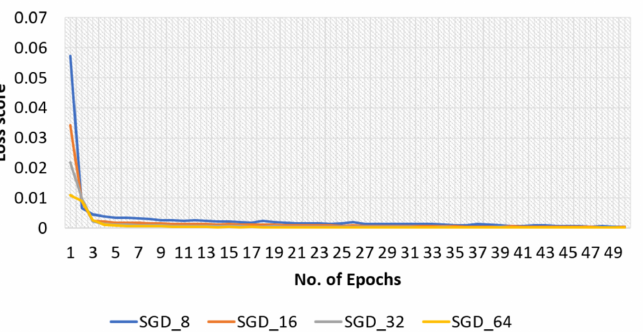
Figure 14. Accuracy curves of ( a ) training and ( b ) test phases of the proposed model obtained with modified dataset and SGD optimizer.